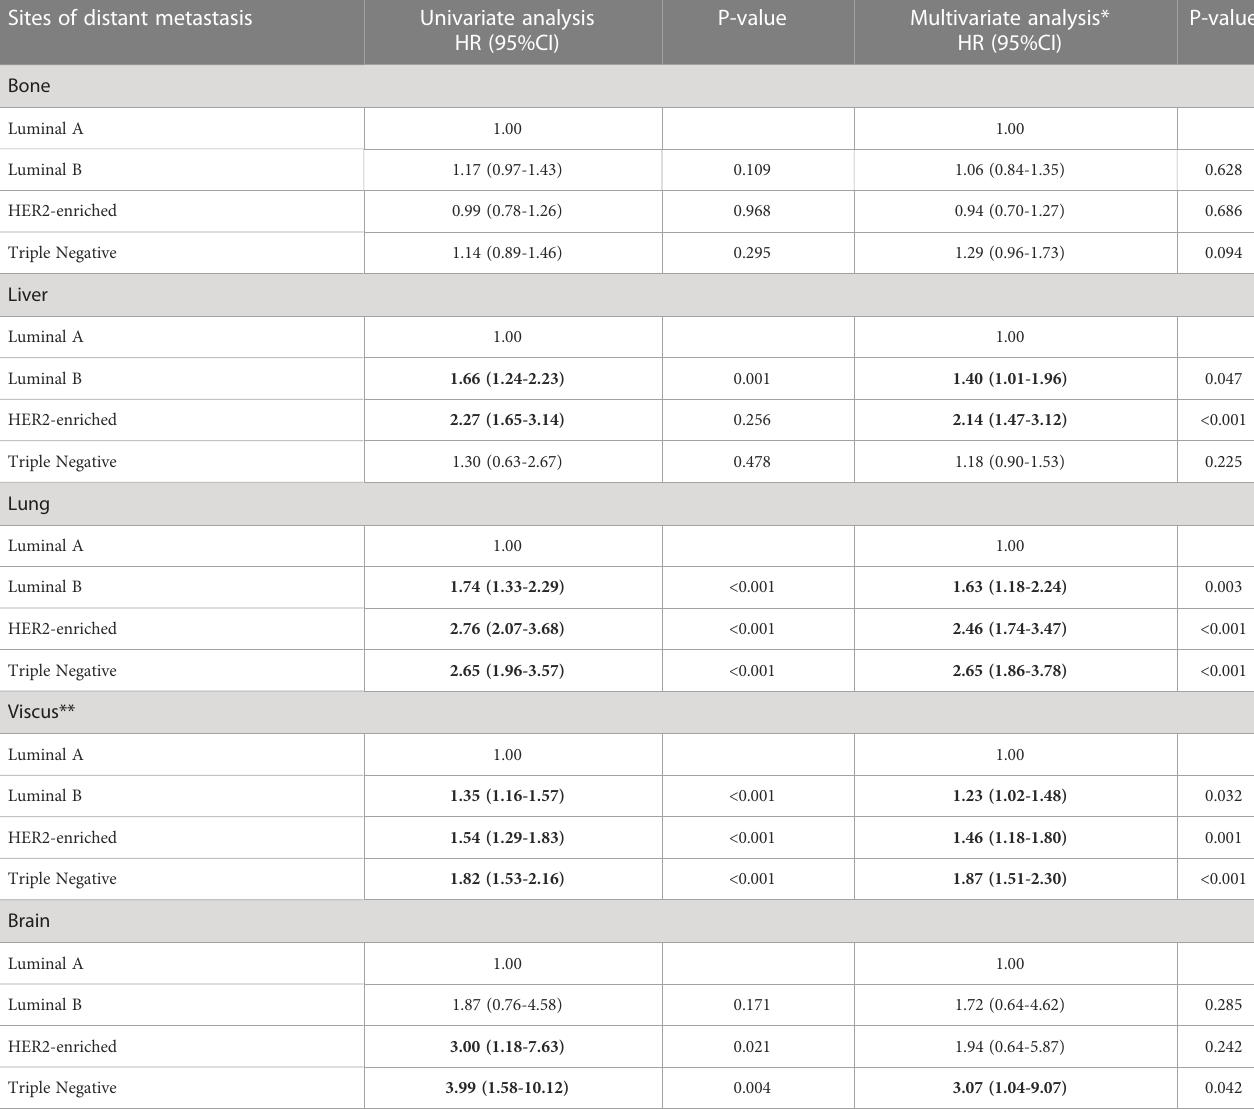
TABLE 4 HRs and 95% CIs for the associations between molecular subtypes and the sites of distant metastasis in advanced breast